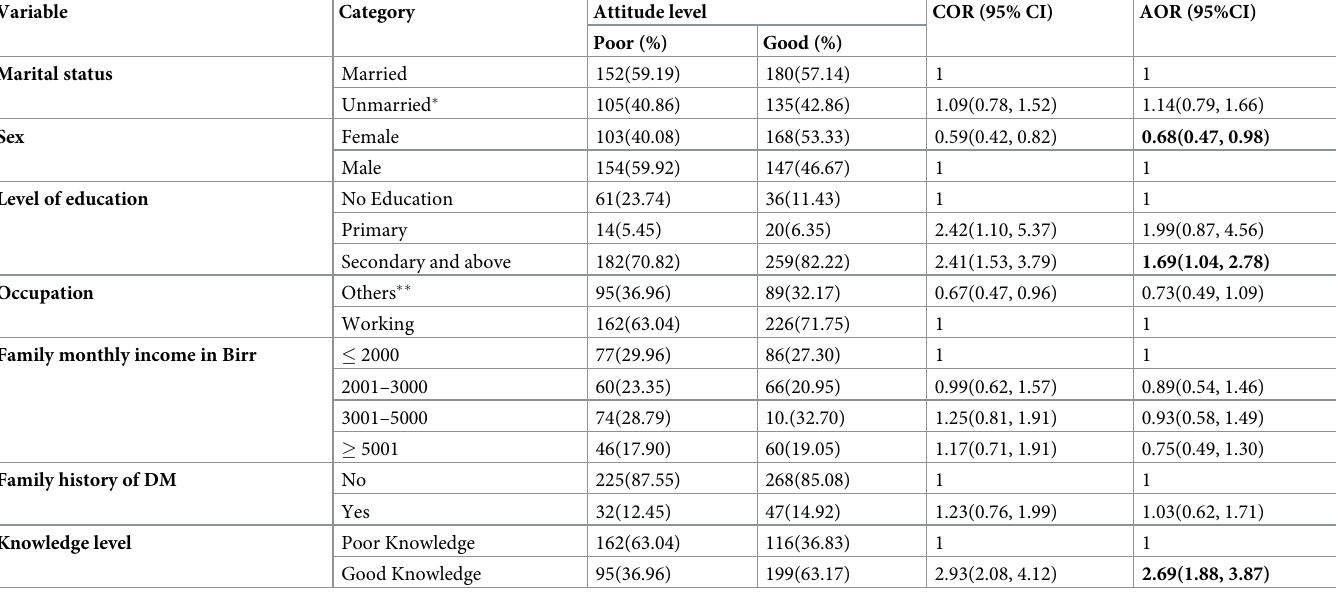
Table 3. Bi- variable and multivariable logistic regression predicting DM related to attitude level among adult non-diabetic participants in Gondar city, Ethiopia 2019 (n =